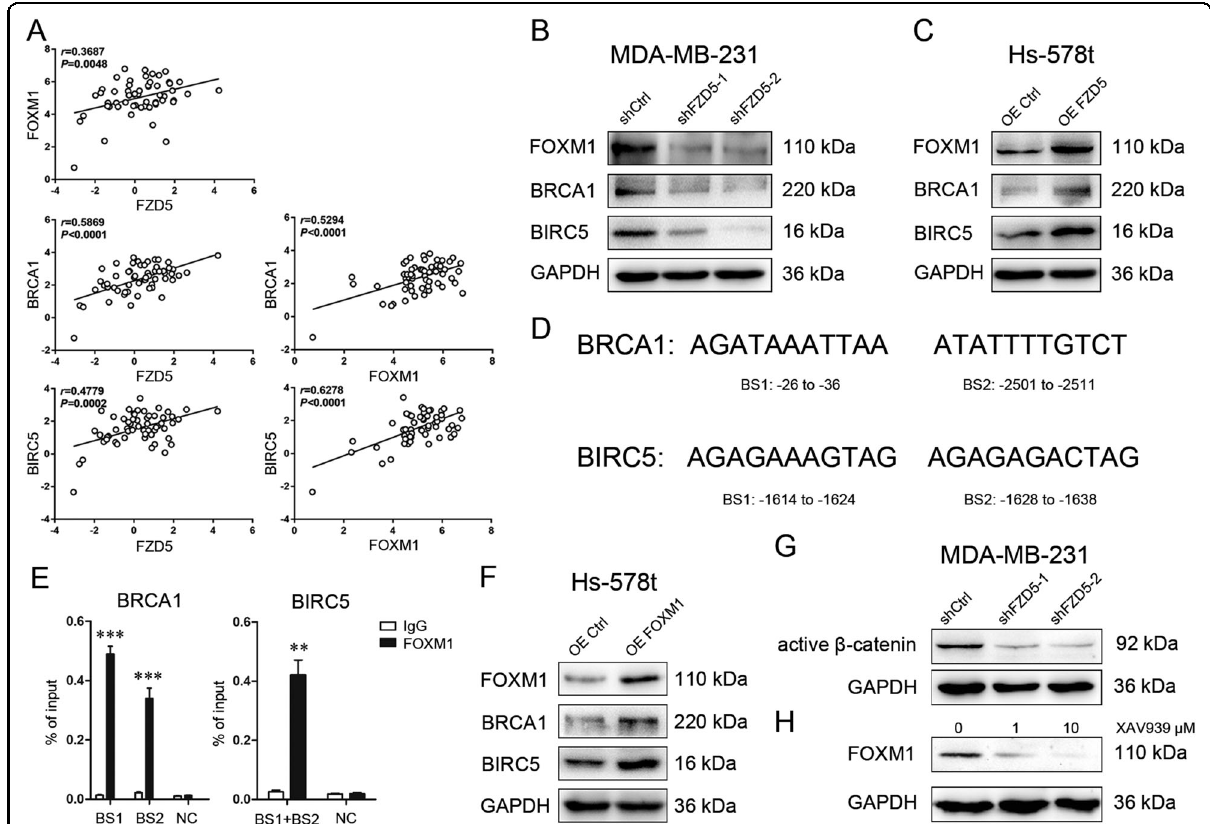
Fig. 6 FOXM1 acts as a downstream effecter of FZD5. A CCLE database was interrogated for FZD5, FOXM1, BRCA1, and BIRC5 expression. Correlation between two genes in a total of 57 breast cancer cell lines was analyzed by Pearson statistics. B FOXM1, BRCA1, and BIRC5 expression in MDA-MB-231 cells was detected by Western blot. C FOXM1, BRCA1, and BIRC5 expression in Hs-578t cells was detected by Western blot. D Binding sites for FOXM1 on BRCA1 and BIRC5 promoters were shown. E Binding of FOXM1 to BRCA1 and BIRC5 promoters in MDA-MB-231 cells was analyzed by ChIP and real-time PCR, mean ± SD, n = 3. ** P < 0.01, *** P < 0.001, vs. IgG. NC negative control. F FOXM1, BRCA1, and BIRC5 expression in Hs-578t cells was detected by Western blot. G Active β -catenin expression in MDA-MB-231 cells was detected by Western blot. H FOXM1 expression in MDA- MB-231 cells was detected by Western